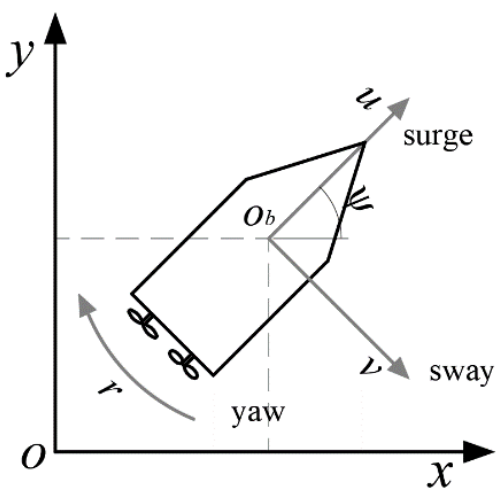
Figure 1. Motions in 3 DOF of